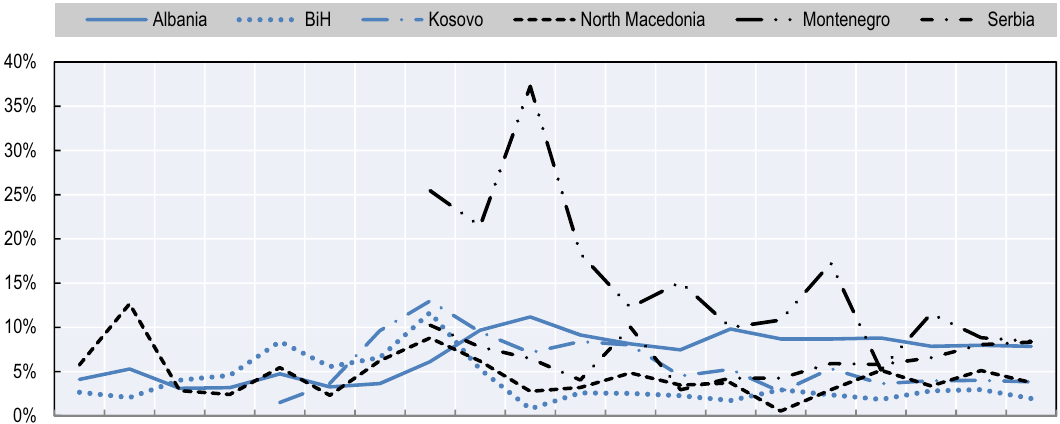
Figure 1: FDI in fl ows as a percentage of GDP ( 2000 – 2019 ) . Sources: UNCTAD ( 2017 ) , World Investment Report 2017: Investment and the Digital Economy, http://unctad.org/en/pages/PublicationWeb fl yer.aspx?publicationid = 1782; for Kosovo: World Bank ( 2017 ) , World Development Indicators 2017 ( database ) ,